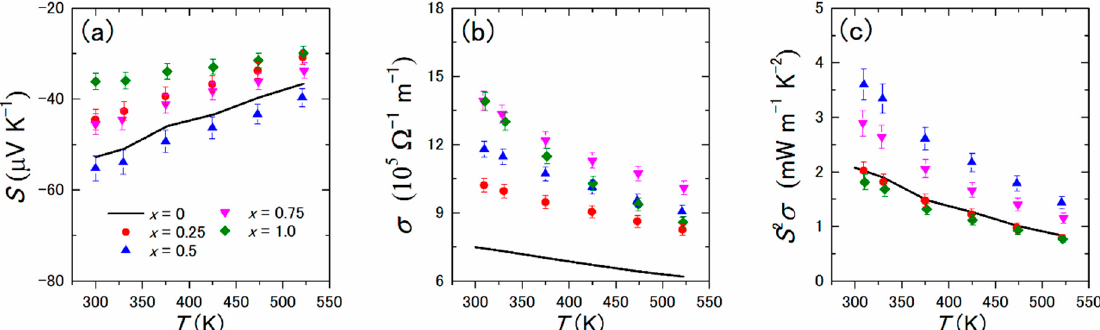
Figure 9. Temperature dependences of ( a ) the Seebeck coefficient S , ( b ) electrical conductivity σ , and ( c ) power factor S 2 σ of polycrystalline bulk samples of Yb(Si 1 − x Ge x ) 2 −δ ( x = 0, 0.25, 0.50, 0.75, and 1.0). Reproduced with permission from Ref. [36]. Copyright 2018, AIP Publishing.